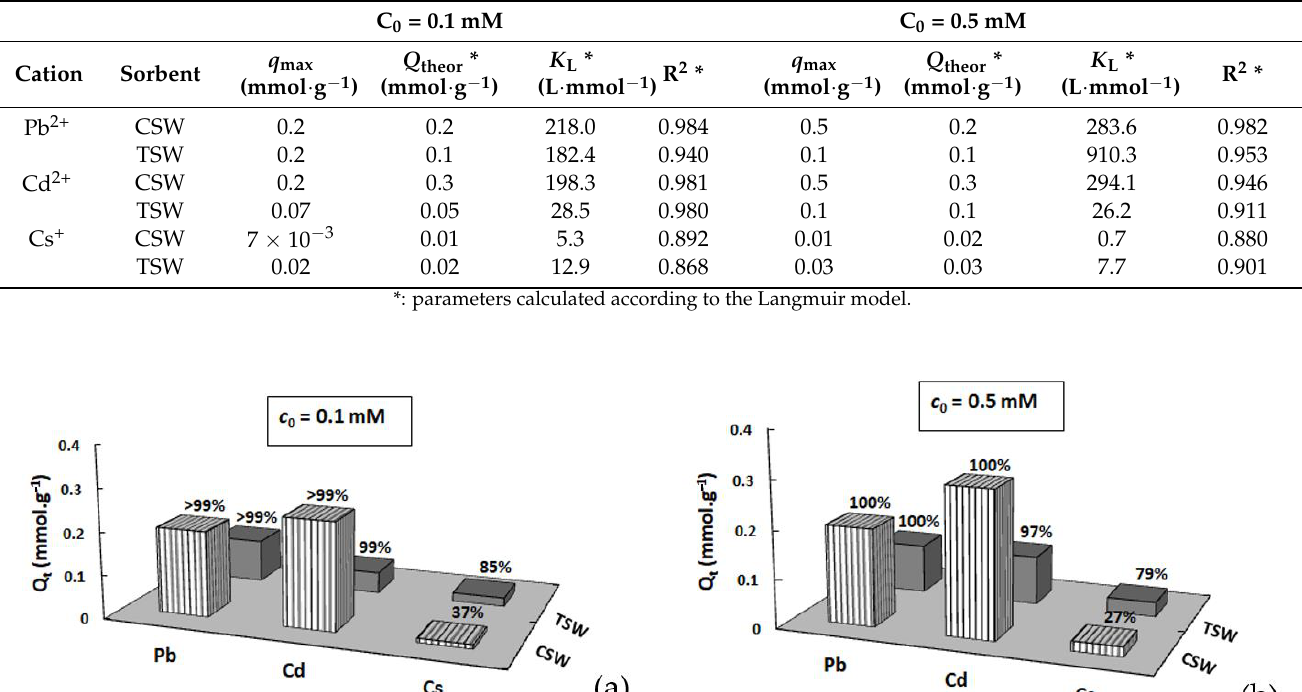
Figure 3. SEM images of CSW and TSW before ( left ) and after ( right ) surface modification (magni- fication of 700x).